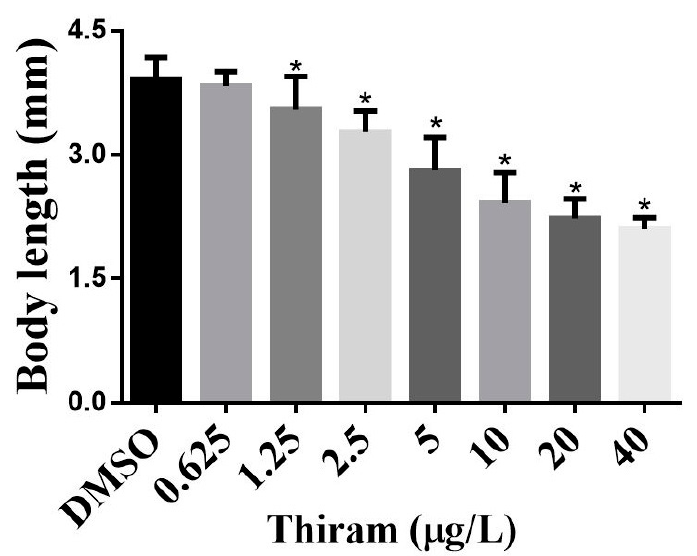
Figure 4. Average body length of zebrafish at designated concentrations of thiram. The body lengths were measured at 144 hpf. Data shown as mean ± SD were obtained from six plates (three independent experiments). Statistical differences were analyzed using an unpaired t -test; * p < 0.05.